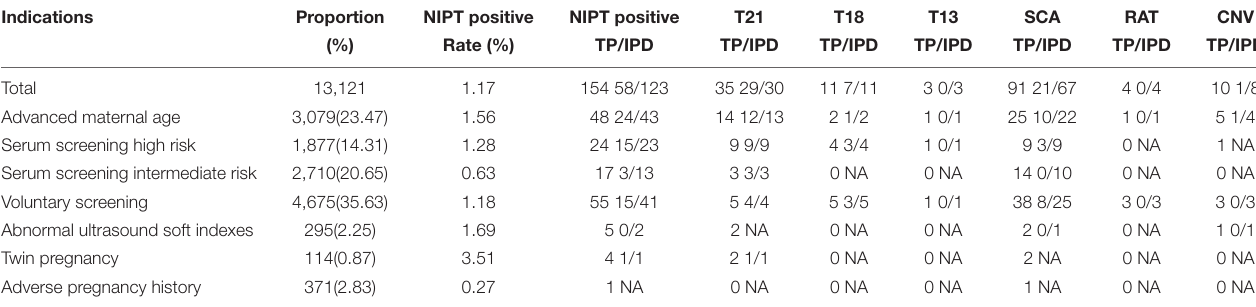
TABLE 1 | Demographic characteristics of pregnant women undergoing NIPT and confirmatory results from January 2015 through December 2017.